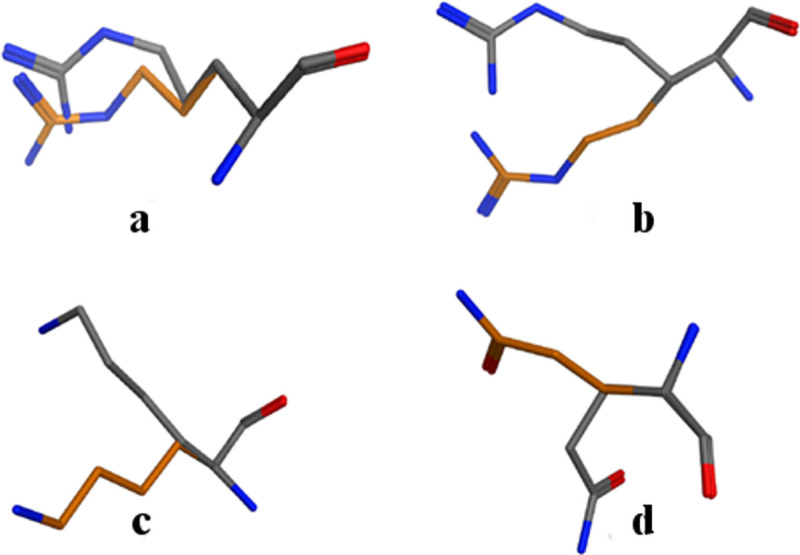
Pairs of residues with various CCM differences (di) superposed on each other.The side chain of Chain A is colored orange and the side chain of Chain B is colored gray. Superposition is based on the backbone alignment algorithm implemented by MOE [42]. a. Arg-282 of 4LLS, di = 0.5000. b. Arg-188 of 3X3Y, di = 1.0001. c. Lys-45 of 2Q20, di = 2.5026. d. Gln-32 of 2ECS, di = 5.0027.